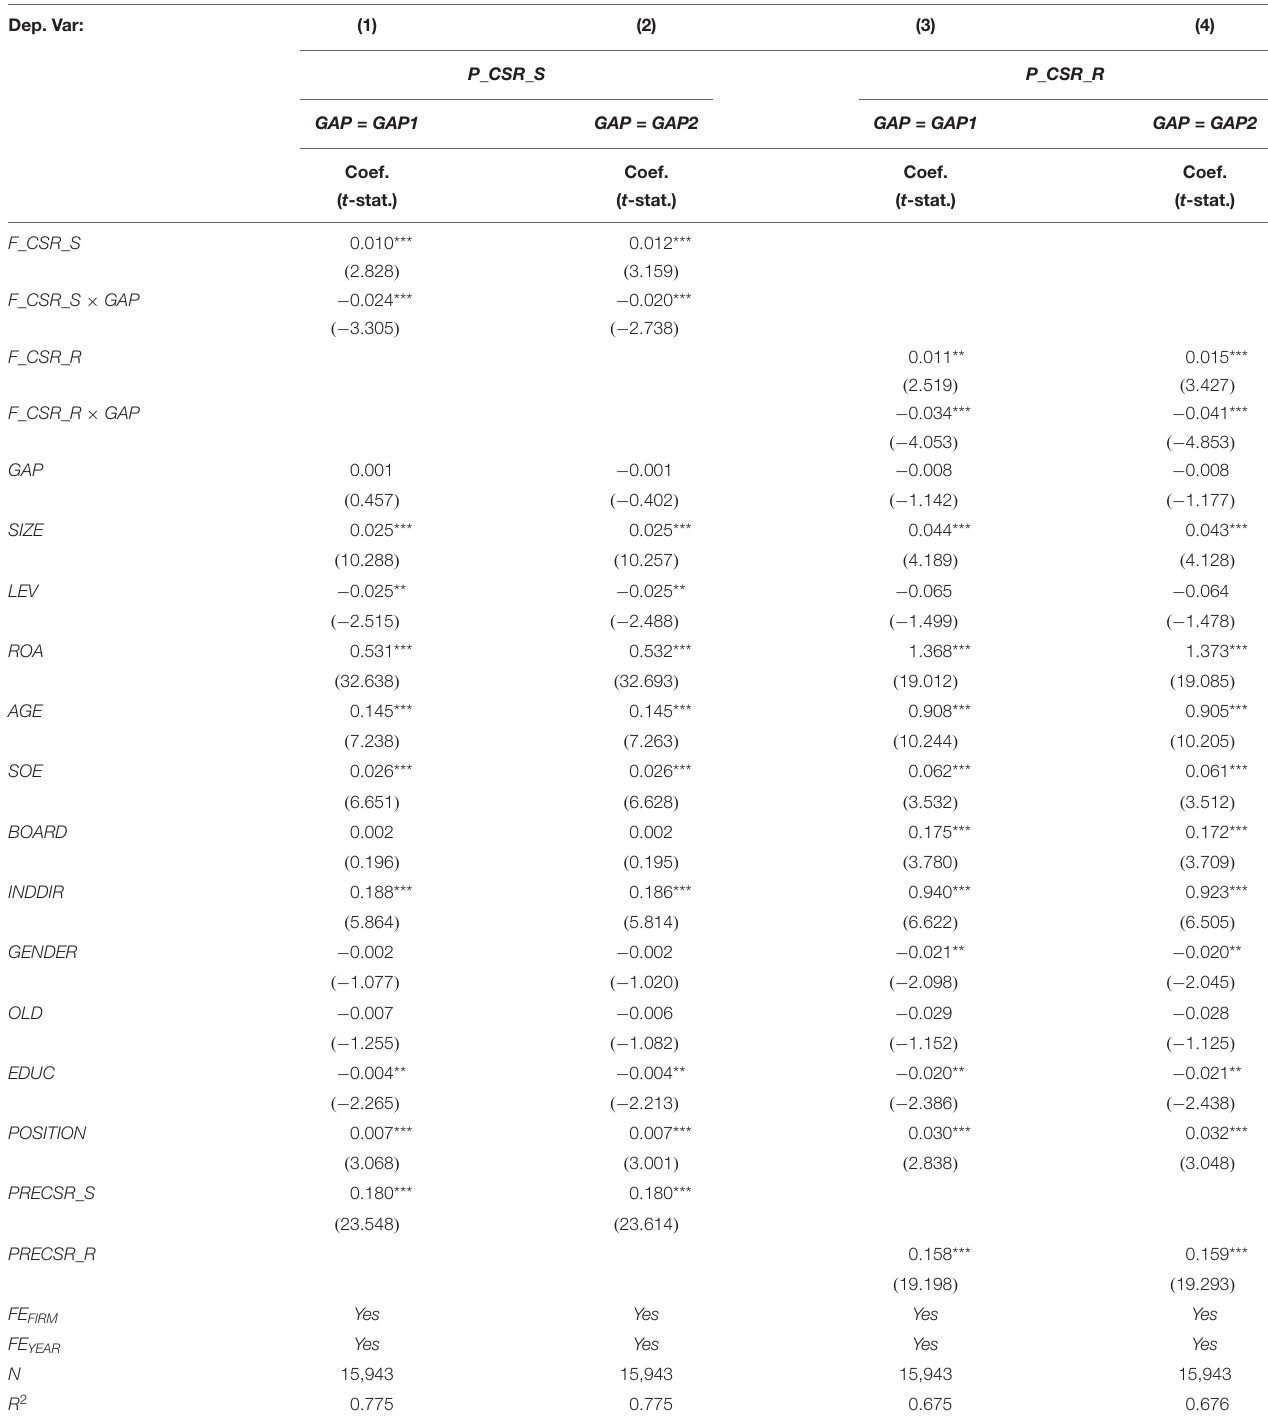
TABLE 6 | Regression results of Model